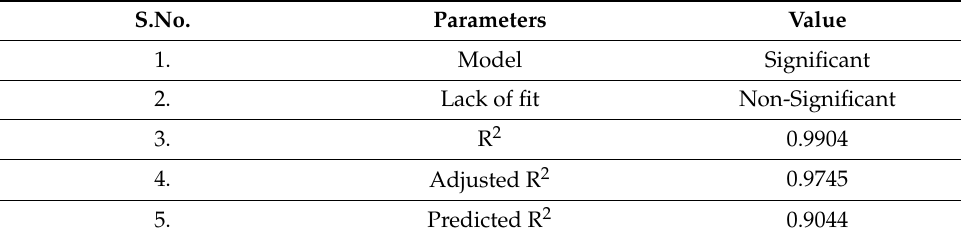
Table 5. Evaluating the RSM